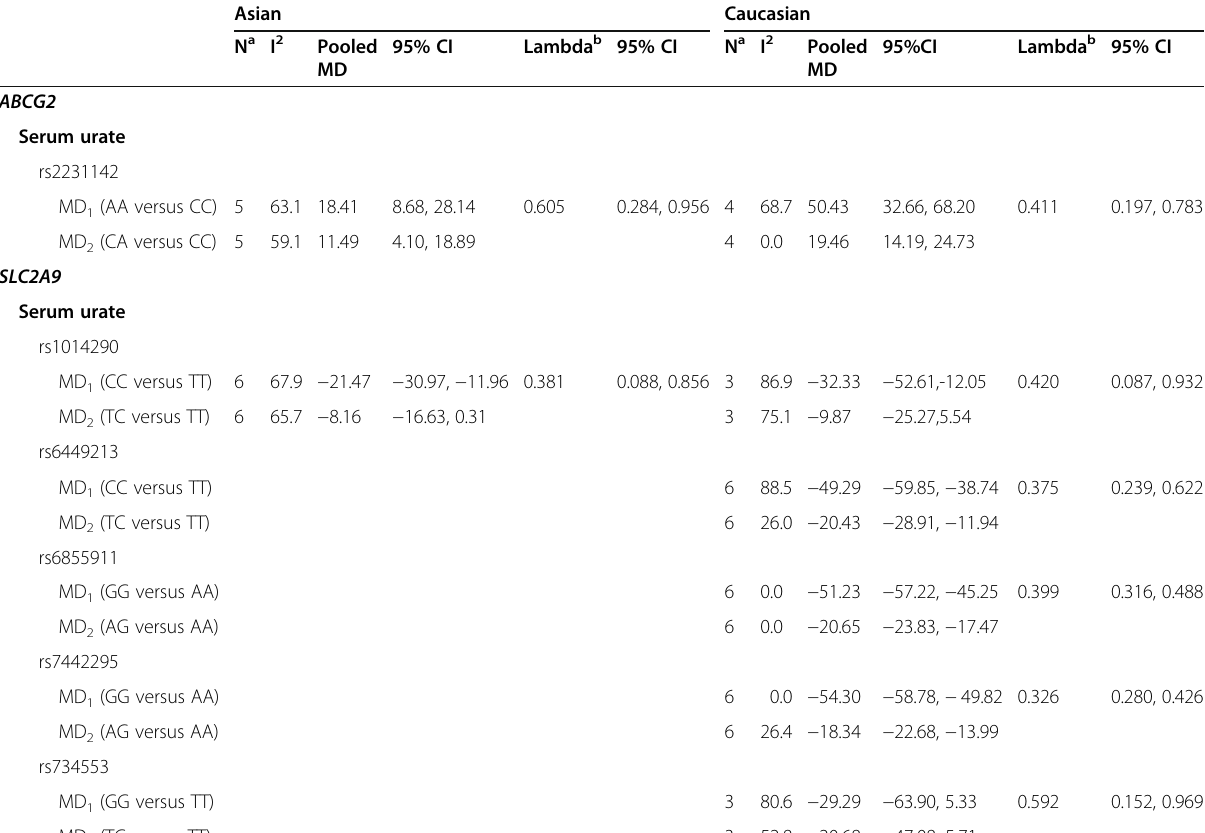
Table 2 Summary of pooled effect sizes of ABCG2 and SLC2A9 polymorphisms on serum urate